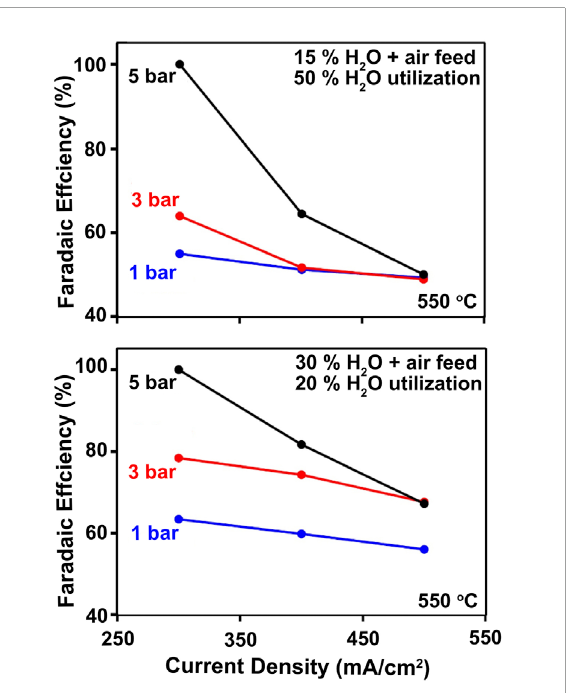
FIGURE 7 Illustration of pressure effect on Faradaic Efficiency at 50% (top) and 20% (bottom) steam